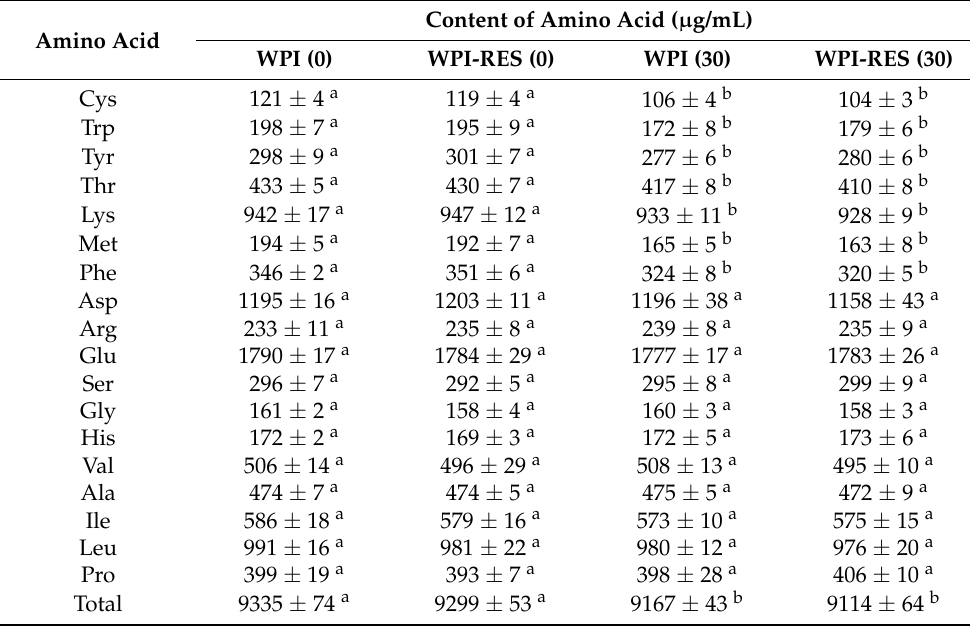
Table 1. Amino acid composition of whey protein isolate (WPI) at 1% in the absence and presence of 100 µ M resveratrol (RES) before and after storage for 30 days.